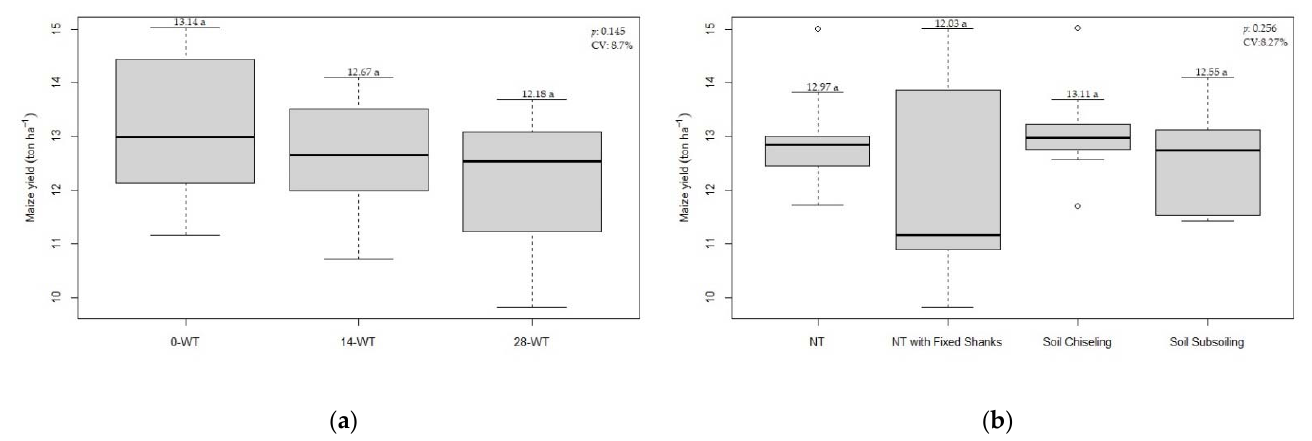
Figure 4. Maize yield for the ( a ) wheel traffic and ( b ) mechanical interventions. Mean values followed by the same letter do not differ according to the Duncan test ( p < 0.10).